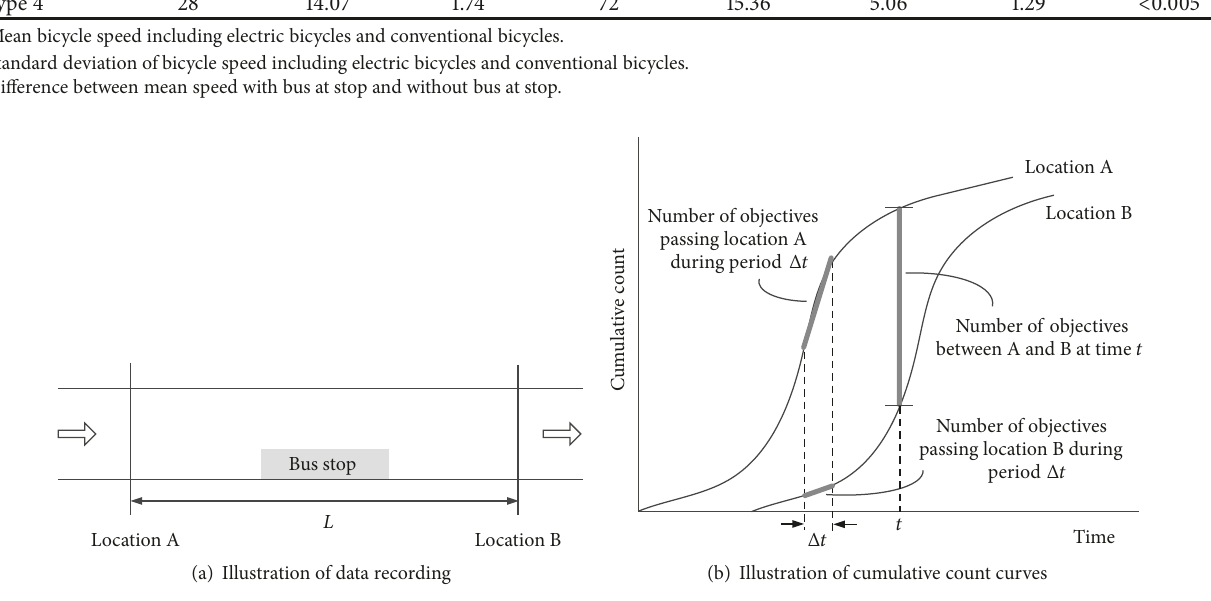
Figure 3: Illustration of data extraction from video